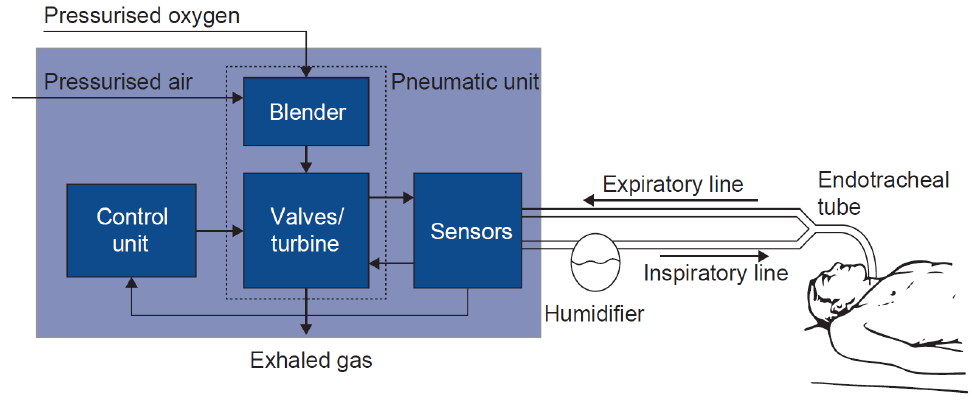
Figure 1. Basic structure and main functional building blocks of a mechanical ventilator (taken and adapted from